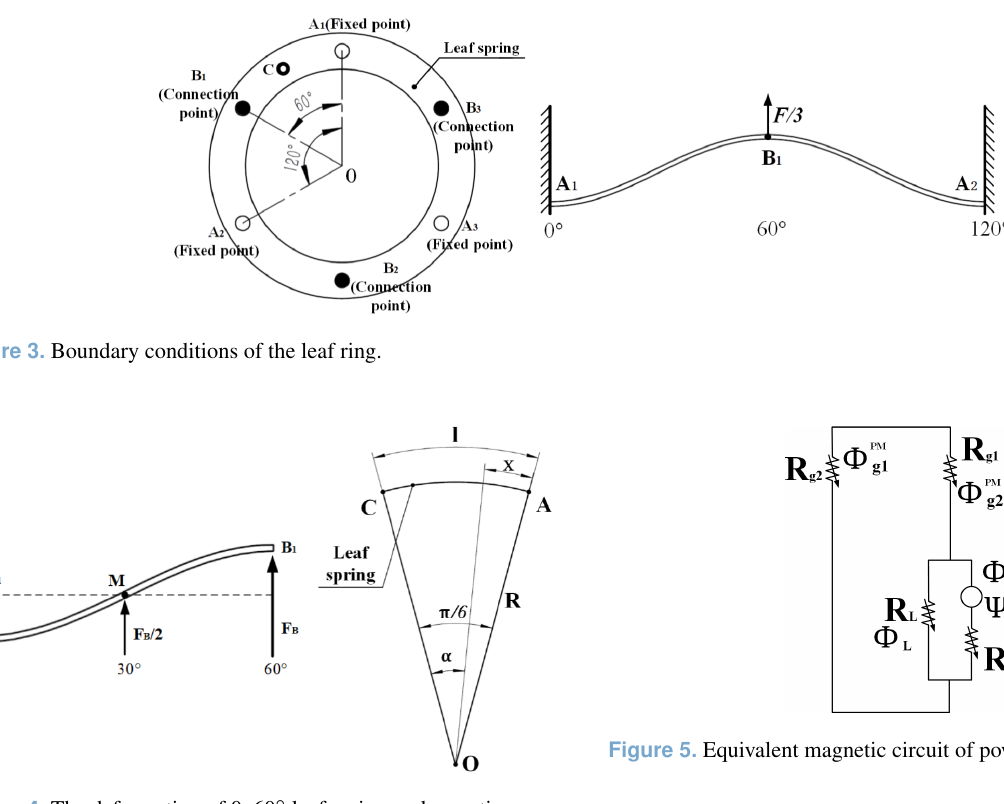
Figure 4. The deformation of 0–60 ◦ leaf spring under suction.